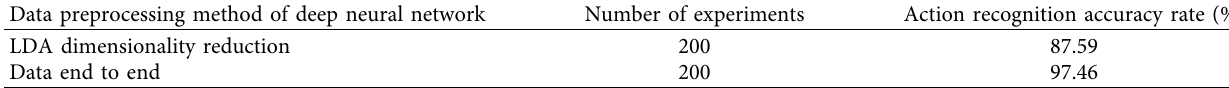
Table 2: Accuracy of different preprocessing